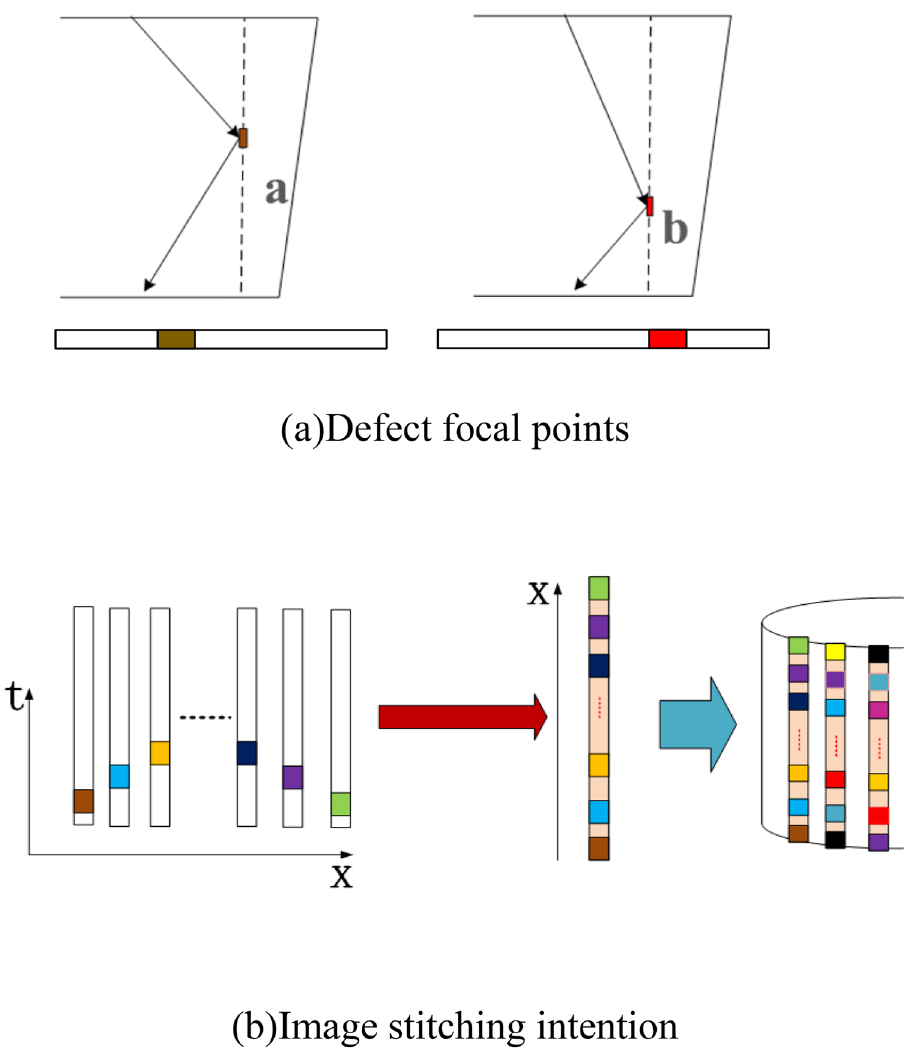
Figure 16. Image process